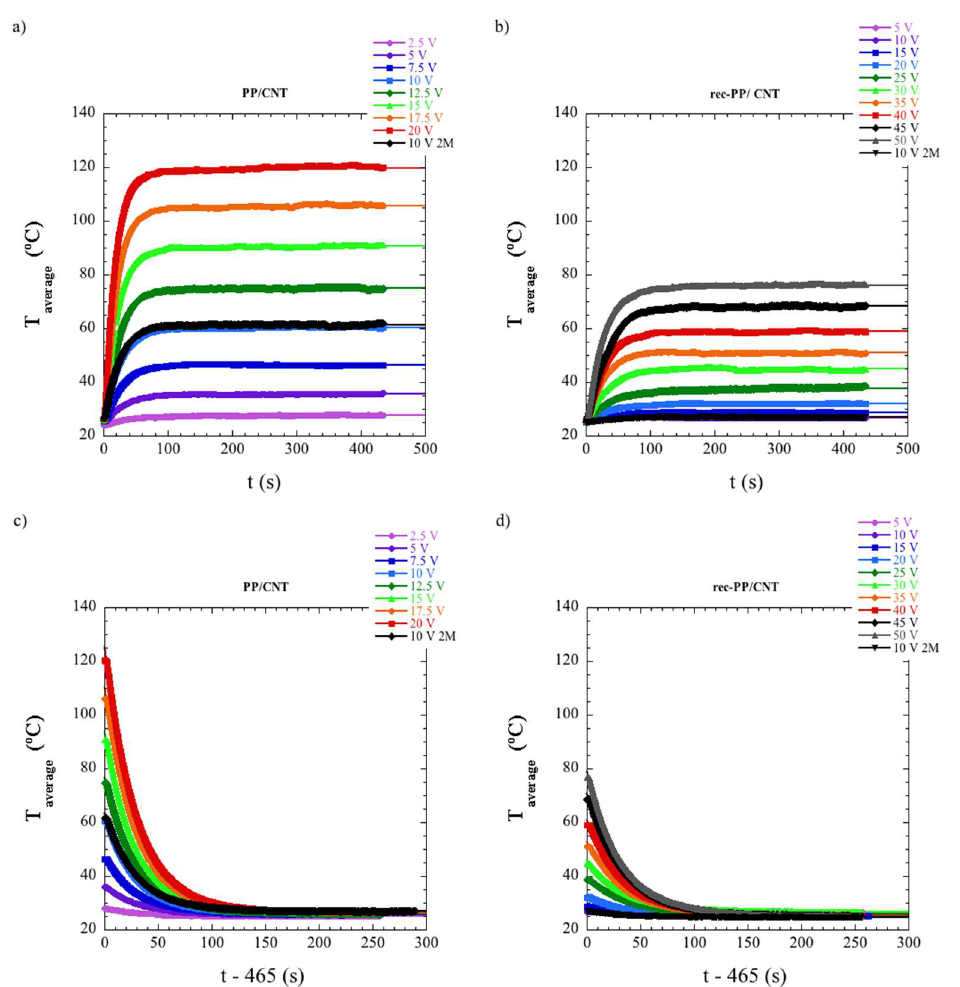
Figure 5. The heating and cooling step of the Joule heating effect is shown for PP nanocomposites. The data are fitted to Equation (1) in the case of the heating step and to Equation (3) for the cooling ( a ) Heating of PP / CNT nanocomposite, ( b ) heating of recycled polymers (Rec-PP) / CNT nanocomposite, process. ( a ) Heating of PP/CNT nanocomposite, ( b ) heating of recycled polymers (Rec-PP)/CNT ( c ) cooling of PP / CNT nanocomposite, and ( d ) cooling of Rec-PP / CNT nanocomposite. 10 V 2M stands nanocomposite, ( c ) cooling of PP/CNT nanocomposite, and ( d ) cooling of Rec-PP/CNT for a second measurement carried out applying 10 V after a first run, to test